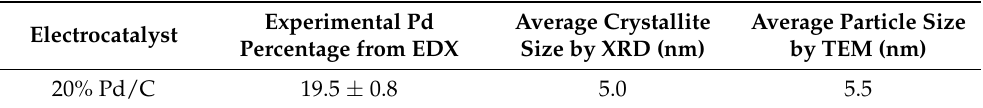
Table 1. Main information extracted from the physico-chemical characterization.